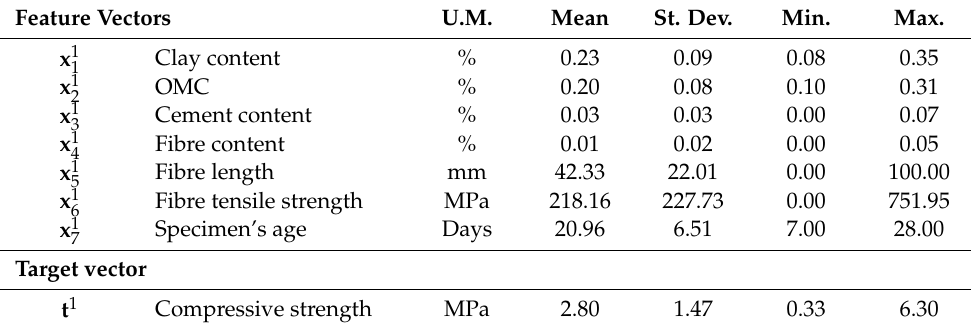
Table 3. Descriptive statistics of the features of Database